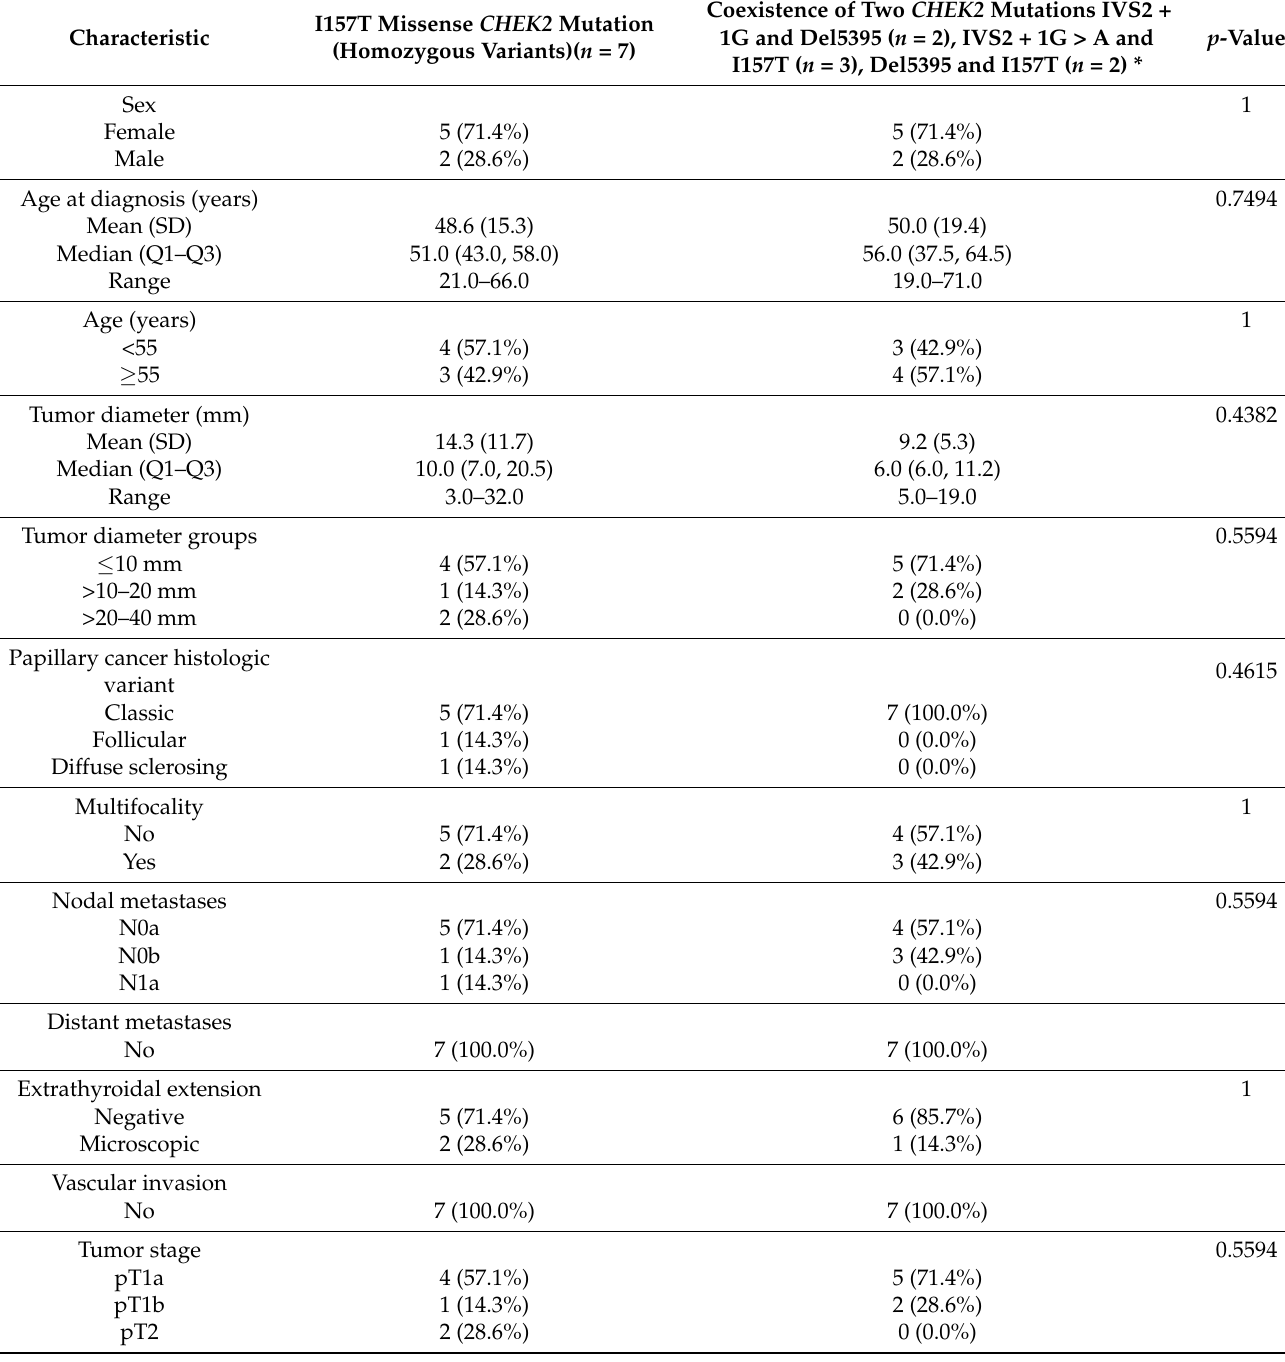
Table 7. Clinical characteristics of patients with PTC carrying two CHEK2